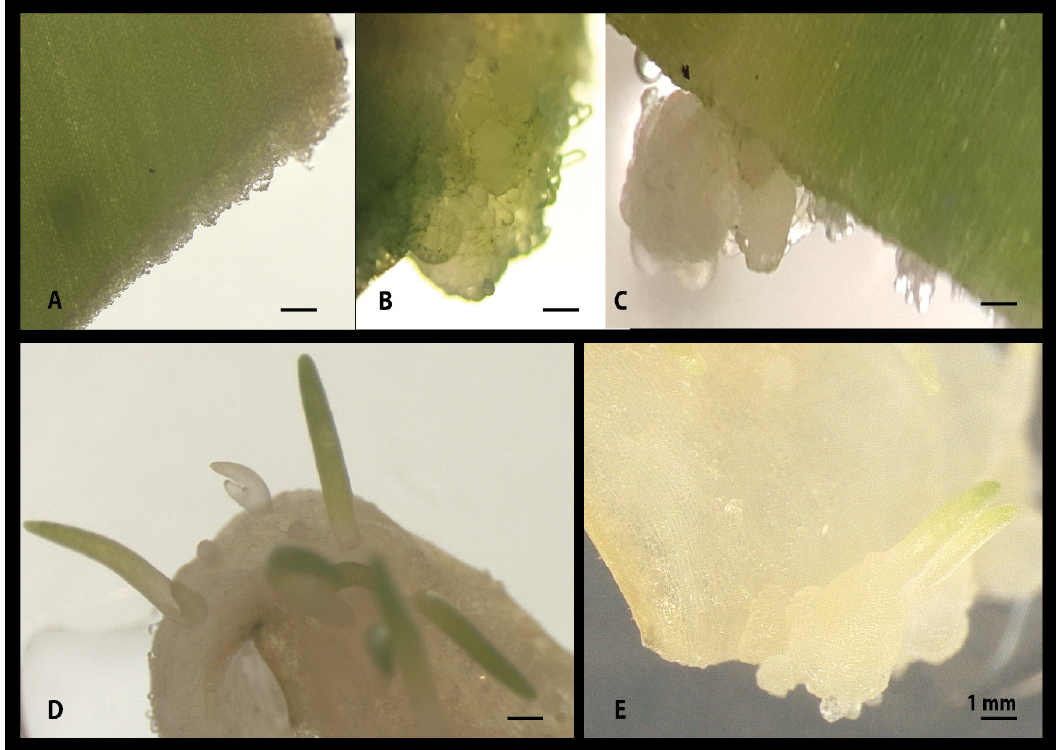
Figure 2. Phloroglucinol mediated organogenesis on O. dubium explants. Panel ( A ) through panel ( C ) show callus types regenerated from O. dubium fragments: ( A ) friable cellular callus type, hard and compacts ( B ), and a mixture of the 2 types ( C ). In panel ( D ), evidence of multiple direct somatogenesis shoots formation without callus induction is shown. In panel ( E ), microbulbs and shooting primordia are shown. Table 2. Phloroglucinol effects on tissue culture of Ornithogalum dubium.